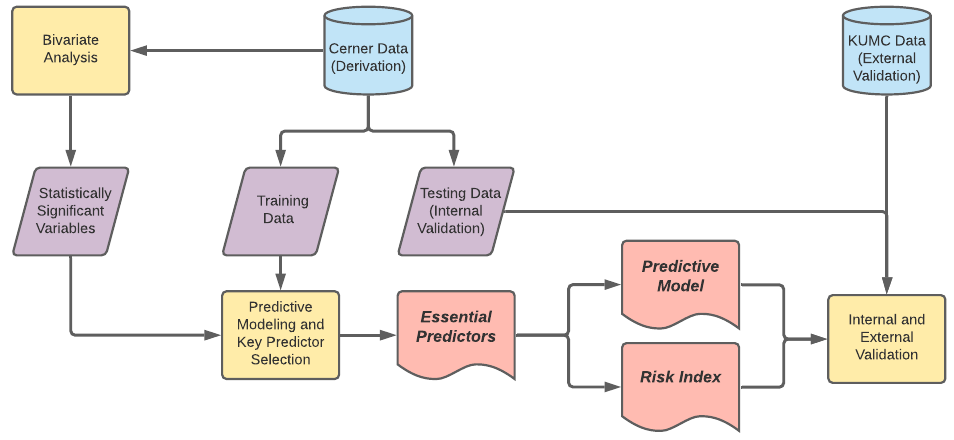
Figure 2. Steps of the derivation and validation